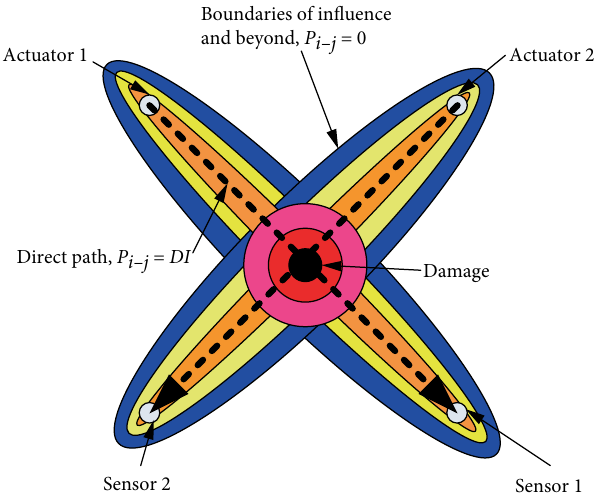
Figure 3: Diagram of probability-based diagnostic